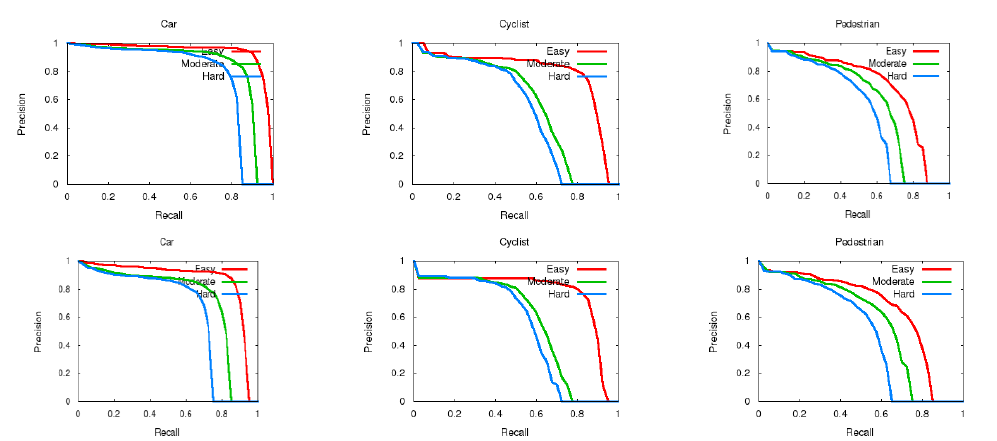
Figure 3. Precision recall (PR) curves for 3D object detection on KITTI val set.